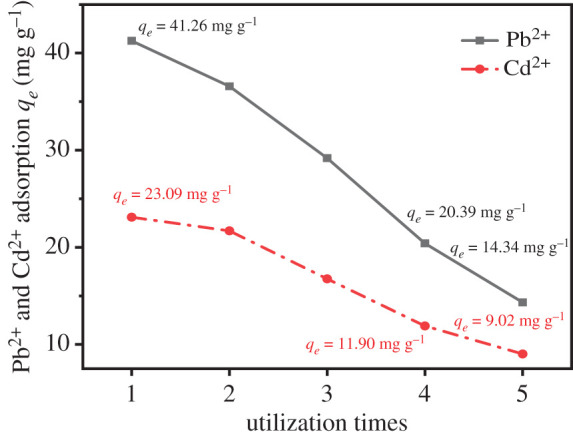
The effect of utilization times on adsorption of Pb2+ and Cd2+.